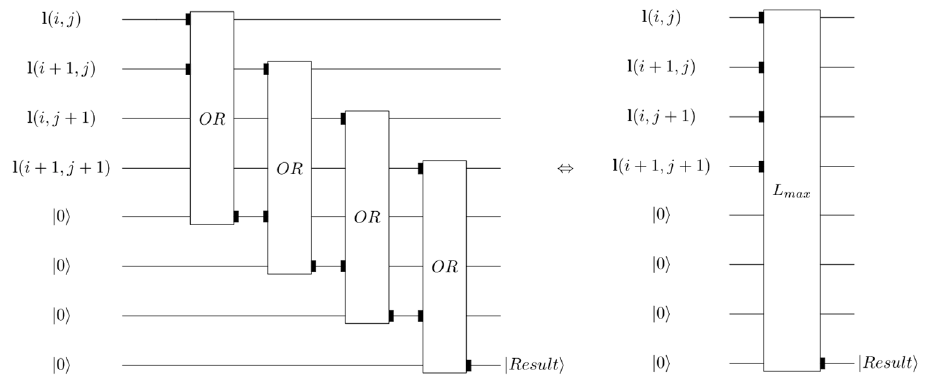
Figure 14. The computation of max l .